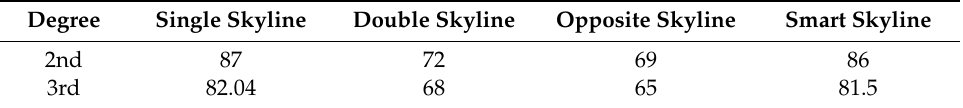
Table 28. Polynomial curve-fitting on the real dataset.